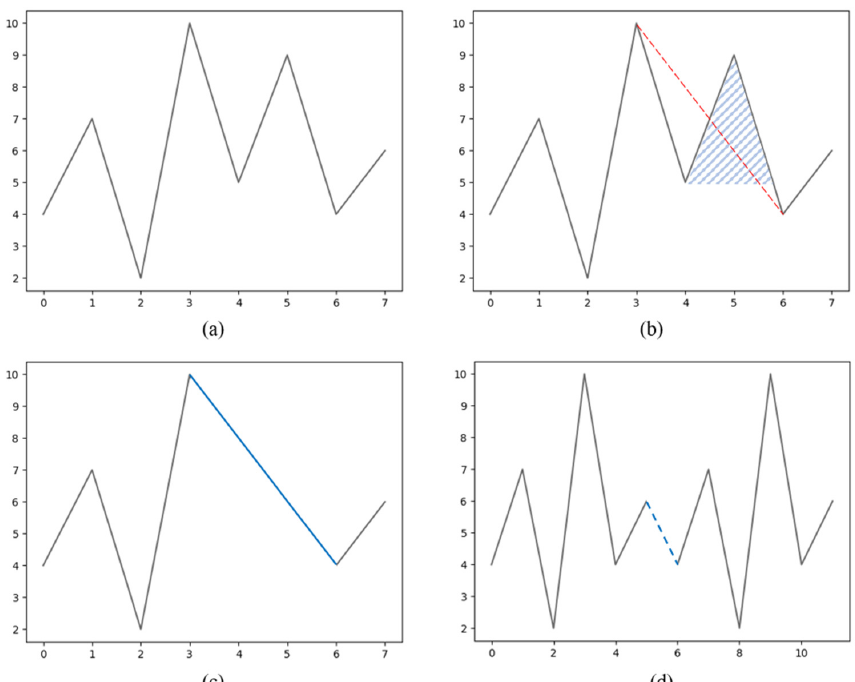
Figure A1. Example of extracting a single cycle using the rainflow counting algorithm. ( a ) It shows a line graph of the original sequence [4, 7, 2, 10, 5, 9, 4, 6] ( b ) Using rainflow counting method extract cycle: 5-9, the depth of this cycle is 4, the average is 7. ( c ) It shows the sequence after the extraction ( d ) Concatenate the original sequence with other sequences.